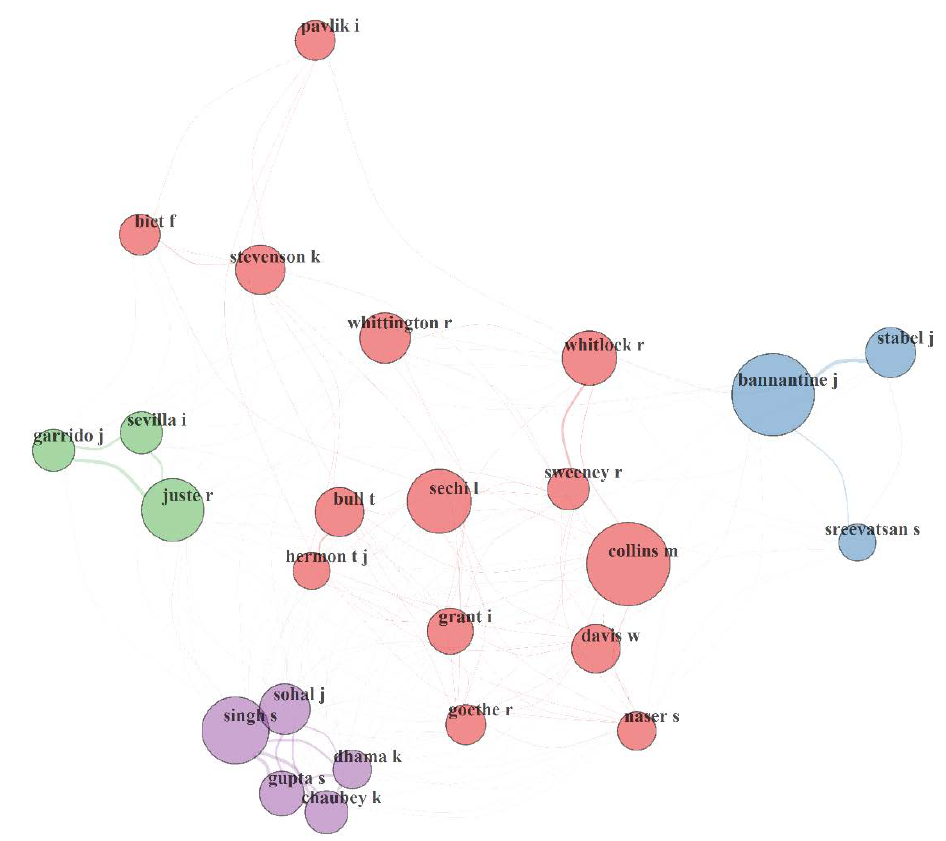
Figure 5. Authors collaboration network (ACN) in MAP research from 1911 to 2019. The collaborative network performance statistics are as listed: size = 6662; density = 0.001; transitivity = 0.387; diameter = 13; degree of centralization = 0.04; average path length = 4.482; closeness of centralization = 0; betweenness of centralization = 0.086; eigenvector of centralization = 0.986; networkDegreeDist = 279. The circle volume of each node (author) correspond to its sharing strength/publication count, connecting curve/line between author nodes indicated bidirectional relationship between the authors; the thickness of the curve/line revealed strength of the bidirectional collaborative/co-author relationships; authors with the same colour or similar coloured link depict that they belong to the same cluster of collaborative/co-authorship community; isolated author(s) or author(s) with no connecting curve with other author(s) is(are) devoid of any collaboration.